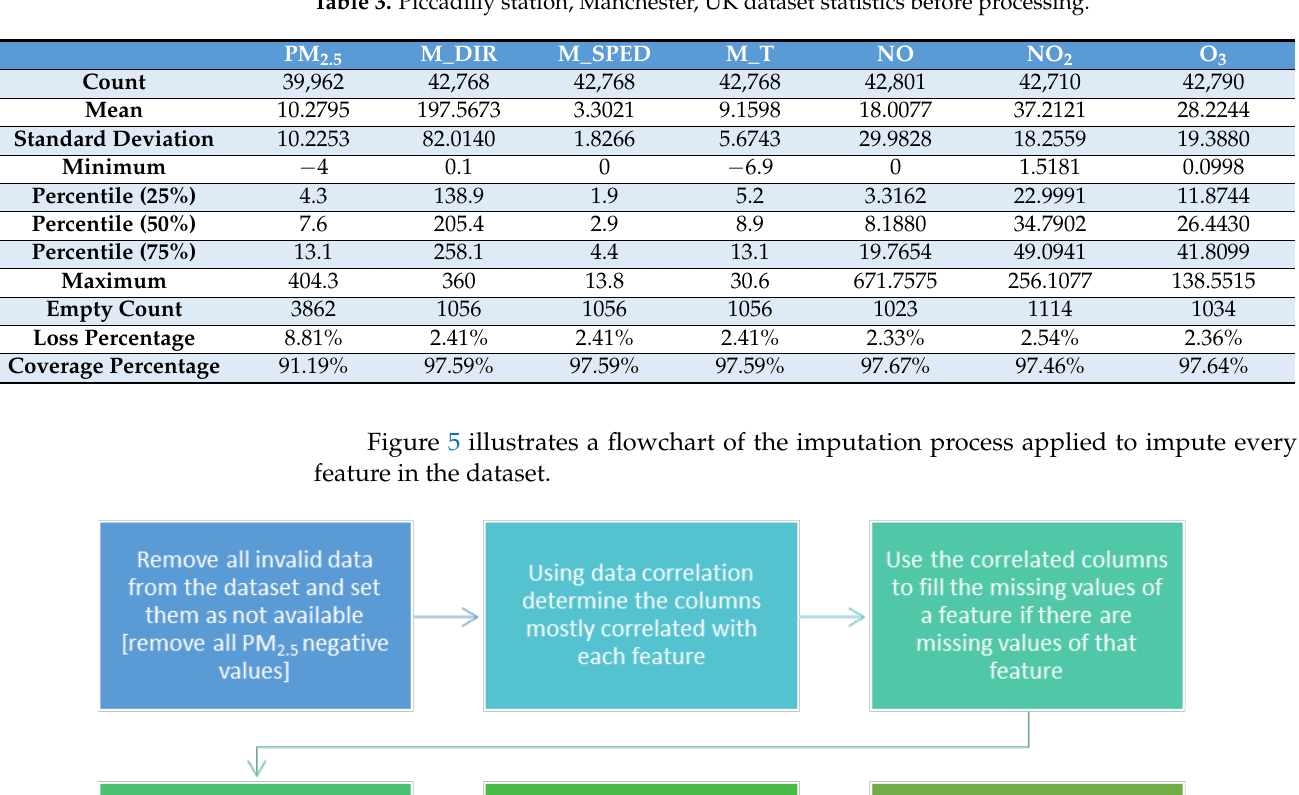
Table 3. Piccadilly station, Manchester, UK dataset statistics before processing.